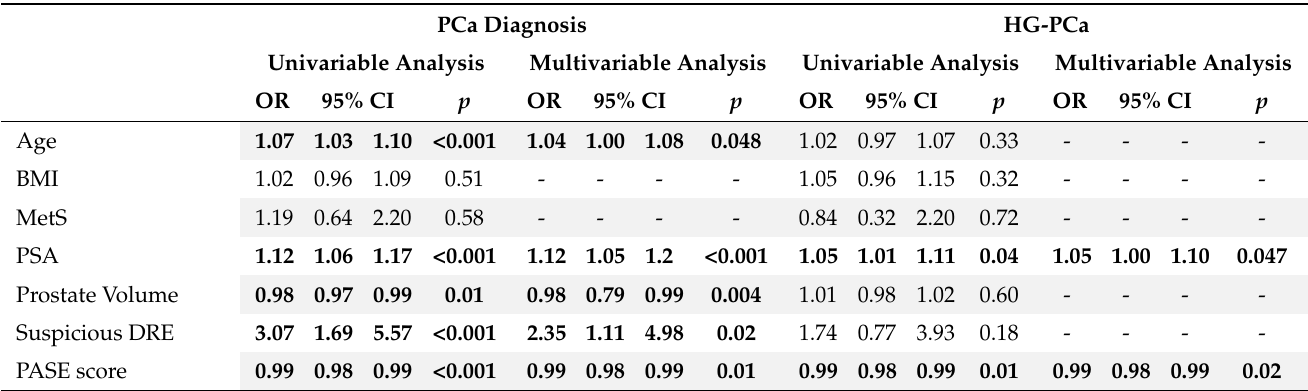
Table 2. Logistic regression analyses to identify predictors of prostate cancer diagnosis and high- grade disease. PCa Diagnosis HG-PCa Univariable Analysis Multivariable Analysis Univariable Analysis Multivariable Analysis